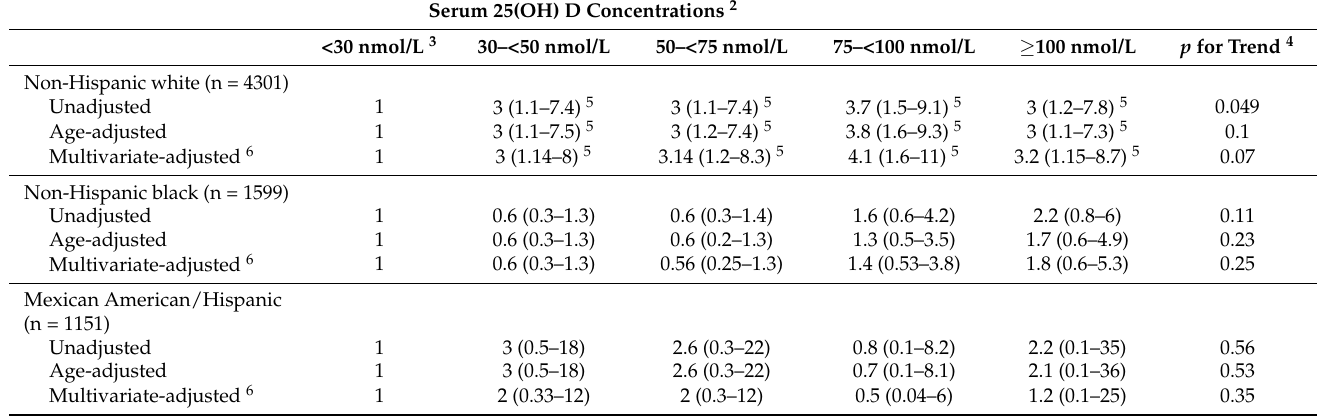
Table 3. Association between serum 25-hydroxyvitamin D [25(OH)D] concentrations and breast cancer prevalence by race-ethnicity in the USA: National Health and Nutrition Examination